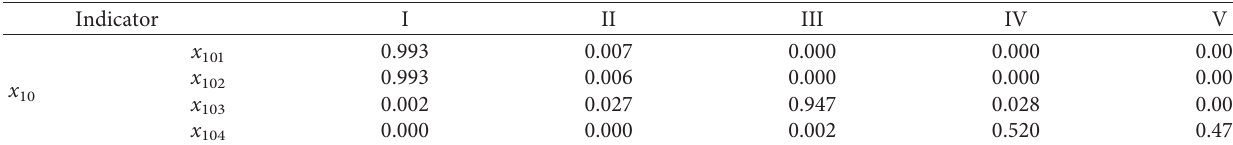
Table 11: Membership degree of social vulnerability